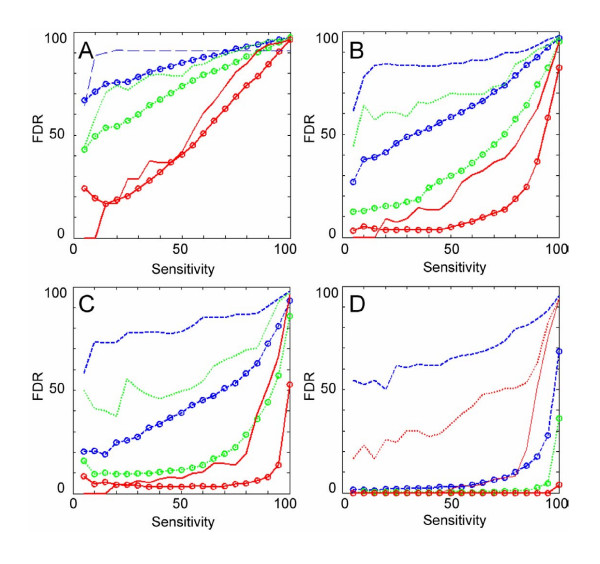
Performance of the scoring procedure. Comparisons were made between two groups of 2, 3 or 5 replicates. The first group is composed of synthetic data sets made from the experimental replicates Wt-t0a and Wt-t0b, in which 200 genes (100 increased and 100 decreased) are changed with different strengths (p <= 0.30(A), 0.10(B), 0.05(C) or 0.01(D)), and the second group is composed of synthetic data sets without extra variation. Ten comparisons with different combinations of data sets were made, and the resulting mean FDR of increased genes is plotted against given values of S (0.05 to 1, by steps of 0.05). Replicates 2, 3 and 5 are, respectively, plotted with blue interrupted, green dotted, and red continuous lines. Lines marked with circles and without circles refer, respectively, to the results of RDAM and SAM. Only one comparison was used for SAM analysis.